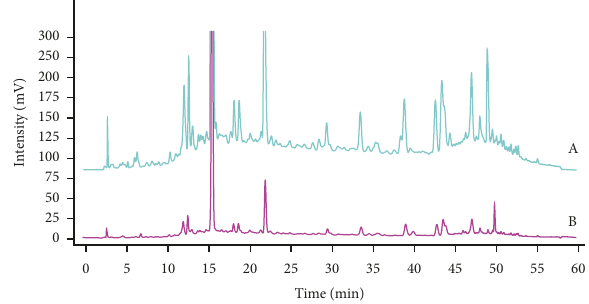
Figure 3: Effect of different concentrations of S22 sample on chromatogram (A for 12 mg/mL, B for 8 mg/mL).